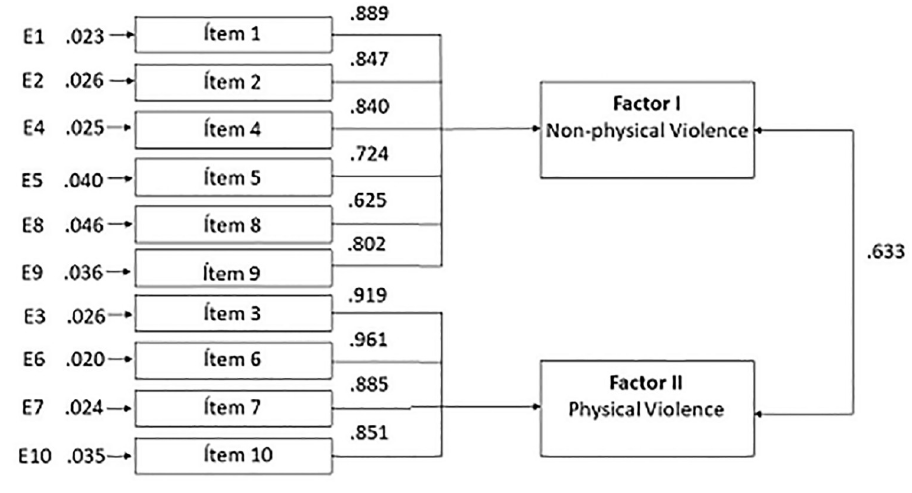
Fig 1. Analysis CFA.